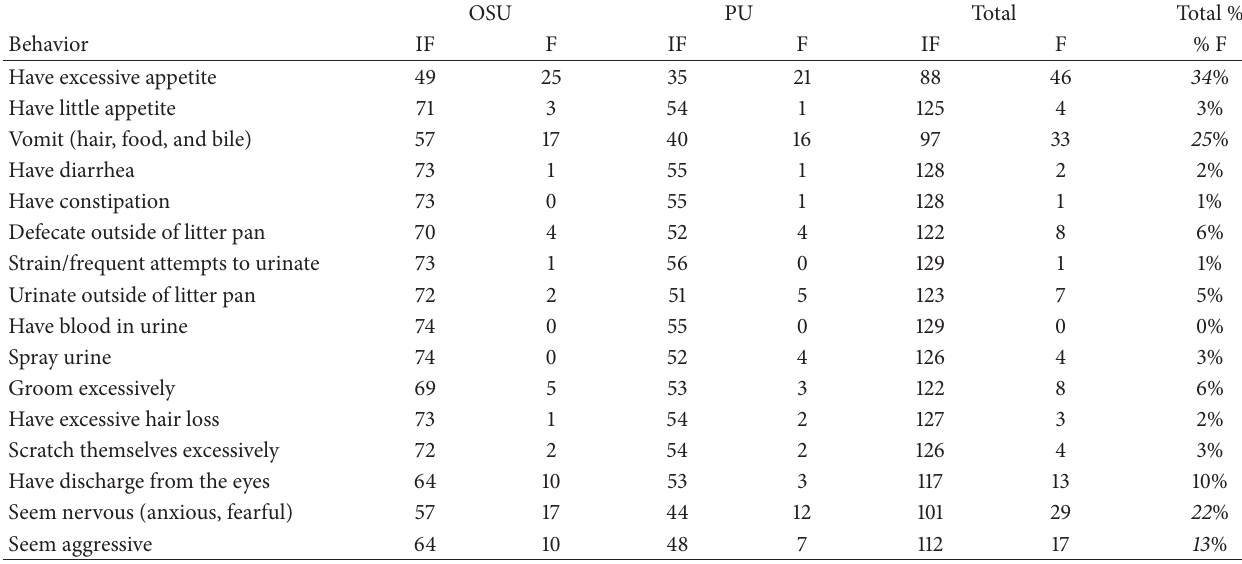
Table 5: Sickness and abnormal